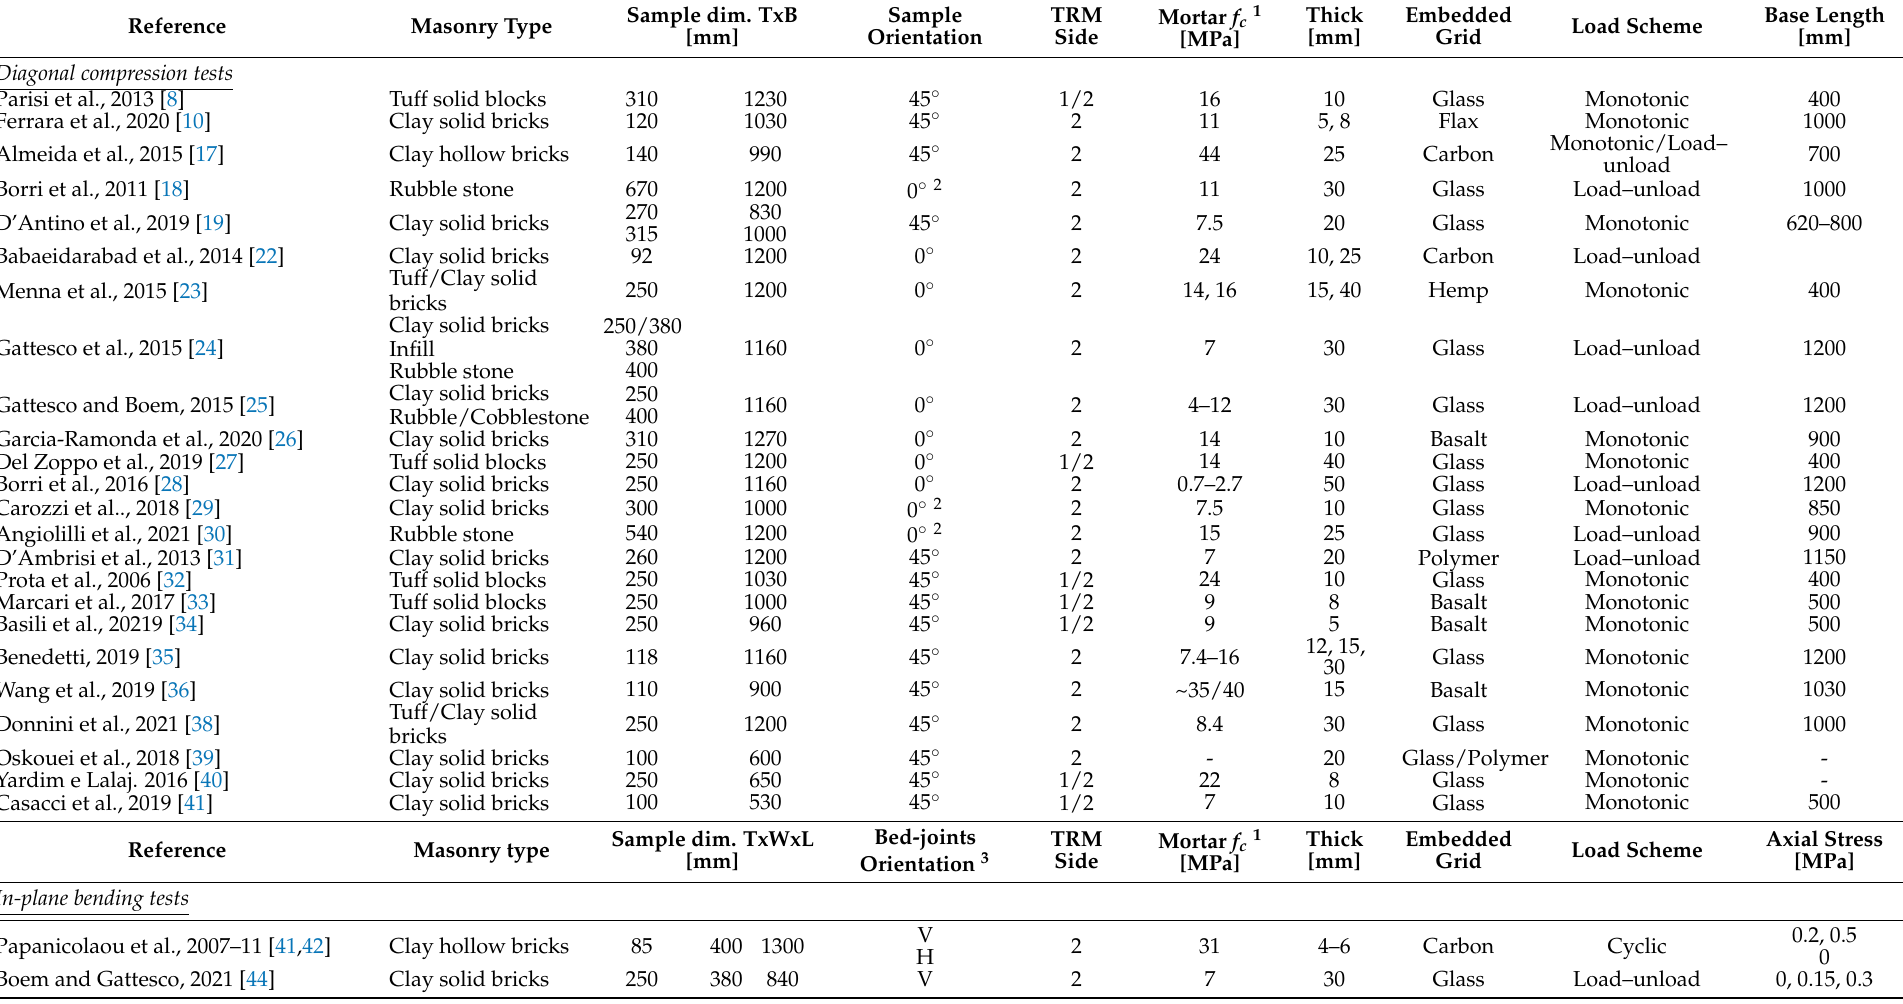
Table 1. Summary of simplified experimental tests on masonry